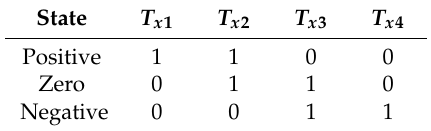
Table 1. Switching state of three-level NPC inverter depending on output